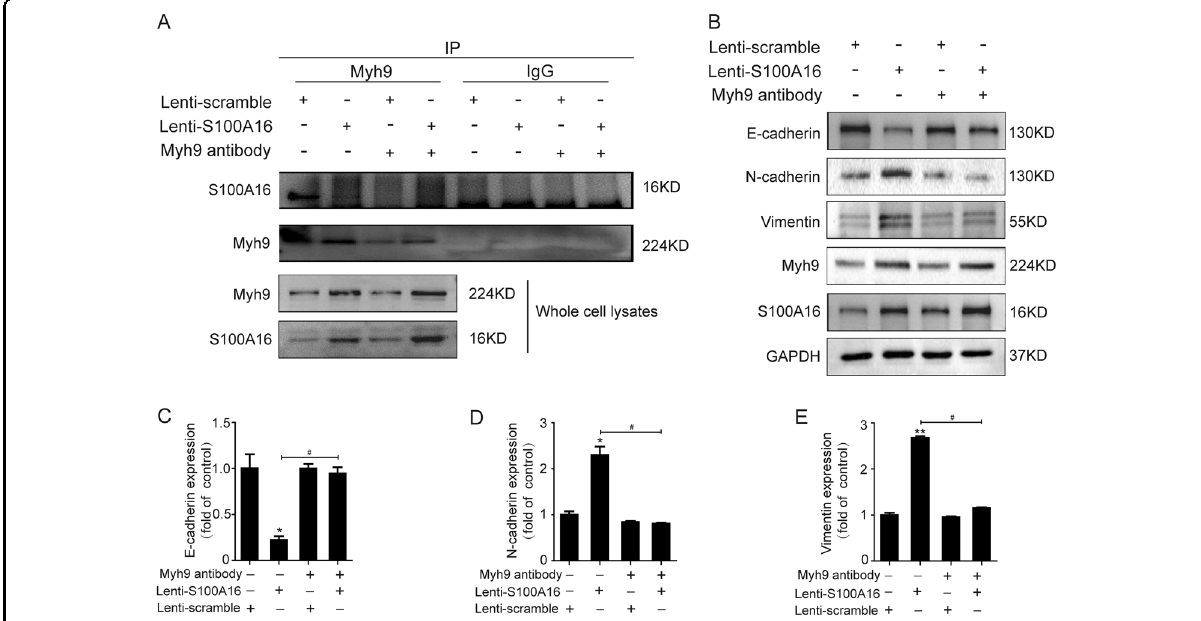
Fig. 6 Myosin-9 is required for the S100A16-induced EMT in HK-2 cells. a Pre-transfection of normal and S100A16-overexpressing (S100A16 OE ) HK-2 cells with the antibody against Myh9 reduced the levels of binding between S100A16 and Myh9. b – e Representative bands of western blots are shown for the expression of Myh9, E-cadherin, N-cadherin, vimentin, and S100A16 in normal and S100A16 overexpressing HK-2 cells after inhibition of Myh9 by antibody transfection. * p < 0.05, ** p < 0.01 vs. scrambles; # p <